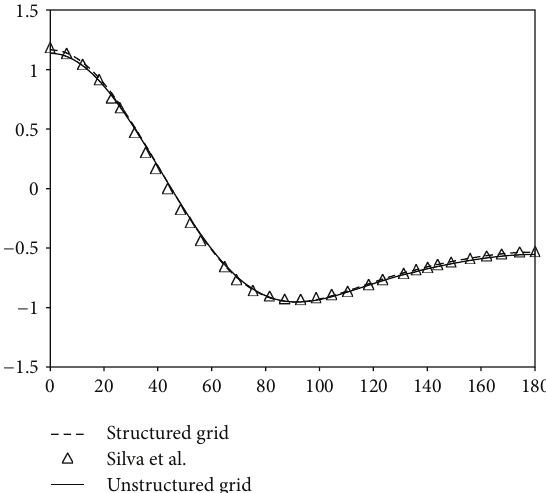
Figure 8: Pressure coefficient distribution, between (𝜃 = 0) and (𝜃 = 180) : Re =